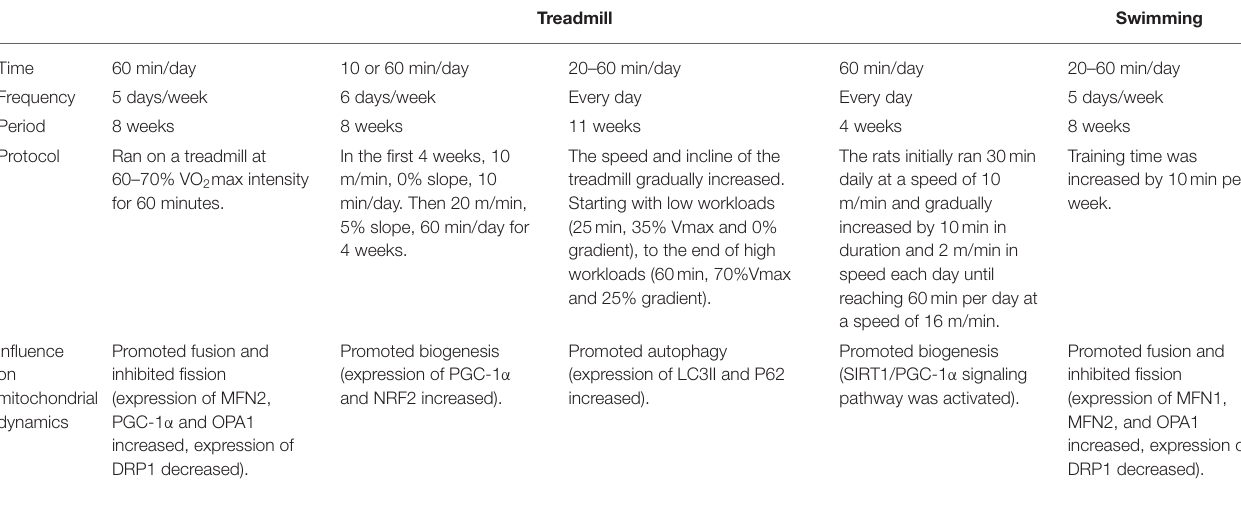
TABLE 1 | Comparison of different exercise training